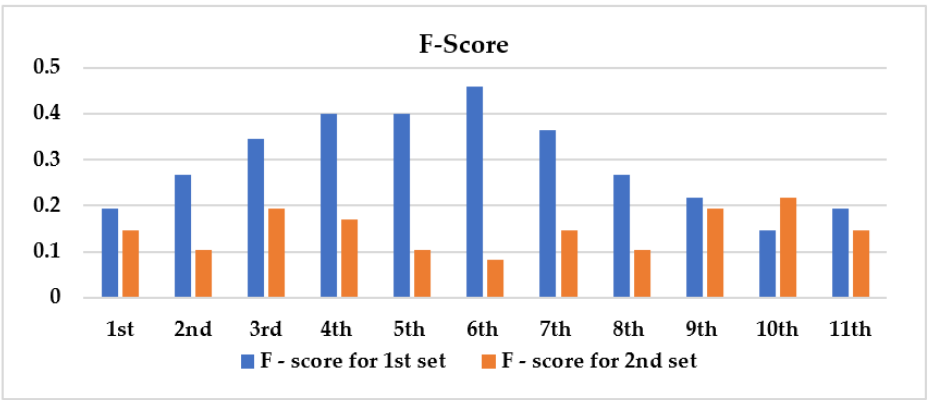
Figure 29. F-score computed for retrieved images for the 1st and 2nd datasets.